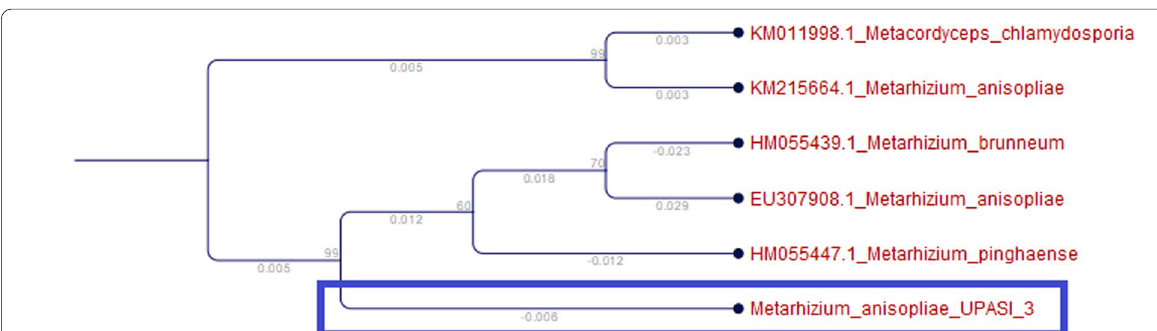
Fig. 3 Phylogenic tree of Metarhizium anisopliae isolate UPASI_3 (MZ930388)